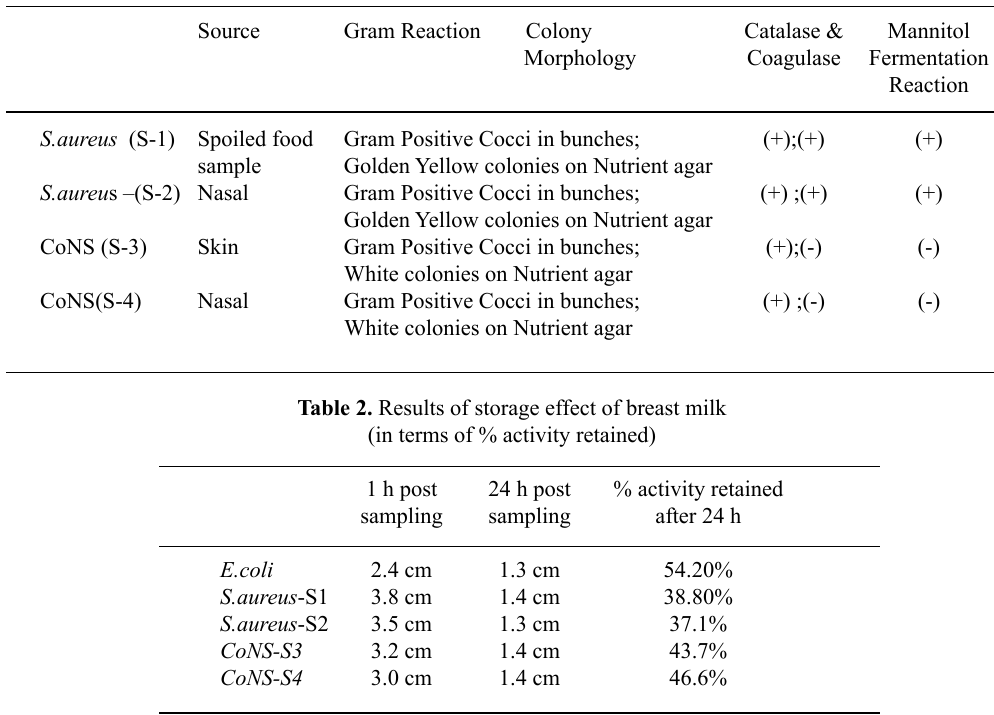
Table 1. Strains isolated and their characteristic features